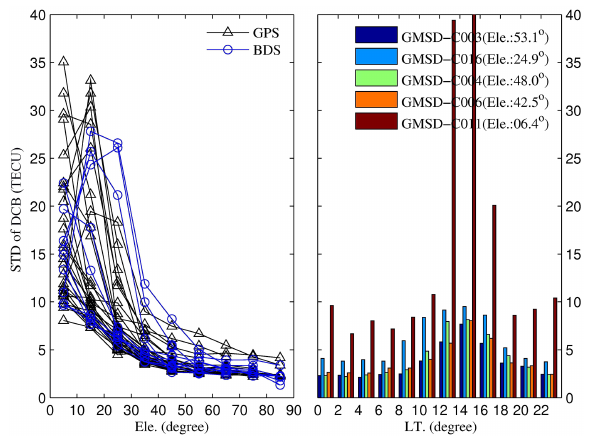
Figure 2. Left panel: standard deviation of DCB with different el- evation angles based on GMSD BDS and GPS observations during 1–7 January 2014. Right panel: standard deviation of DCB with dif- ferent local times based on GMSD BDS GEO observations during 1–7 January 2014.